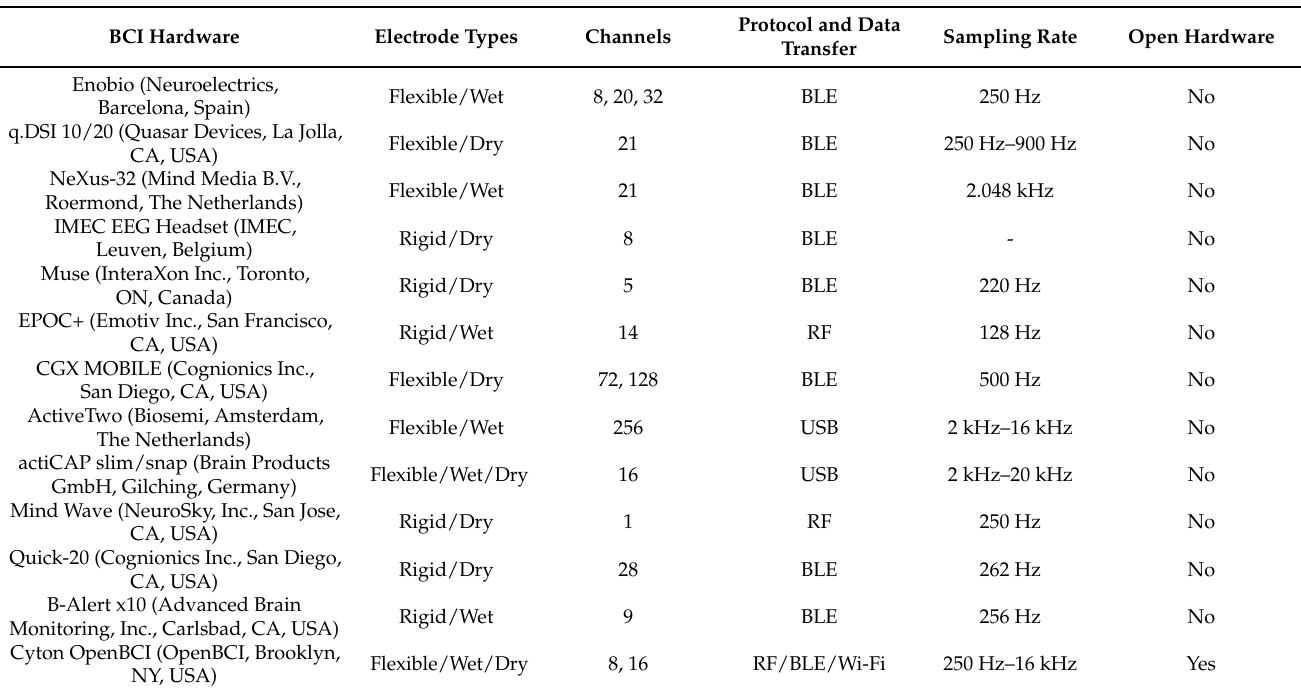
Table 1. Acquisition devices used for BCI. Bluetooth (BLE) devices tend to have slower speeds than Radiofrequency (RF) and Wi-Fi communication protocols. Wired-based data transfers, like USB, have the highest transfer